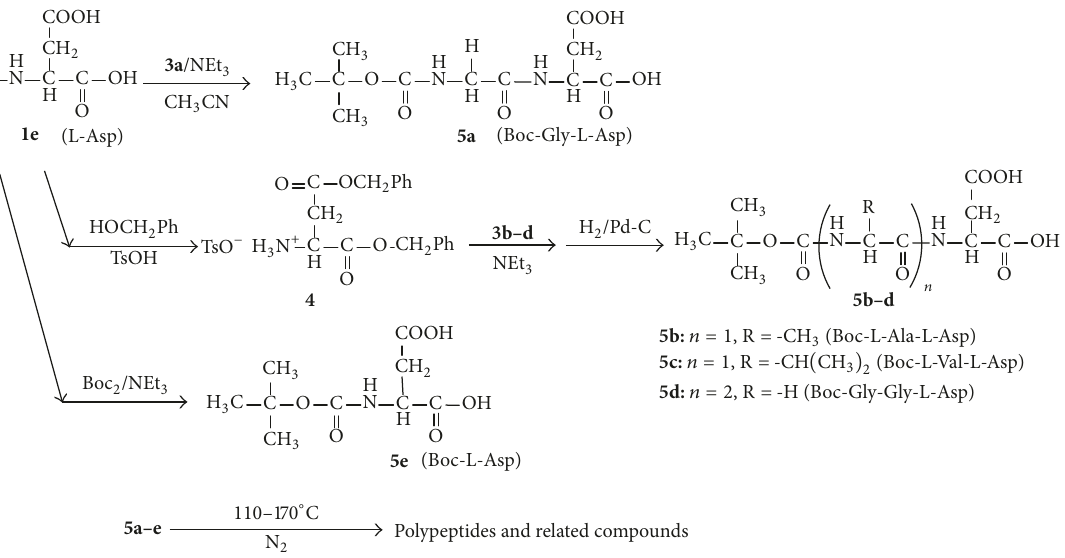
Figure 2: Preparation of N-t-butyloxycarbonyl peptides containing aspartyl residue at C-terminus. TsOH: p -toluenesulfonic acid; TsO-: p - toluenesulfonate; Boc 2 : di-t-butyl